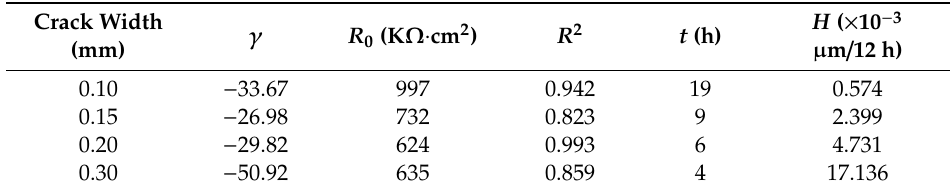
Table 5. Depassivation time and corrosion rate of steel bars in concrete with different crack widths in an electric field.